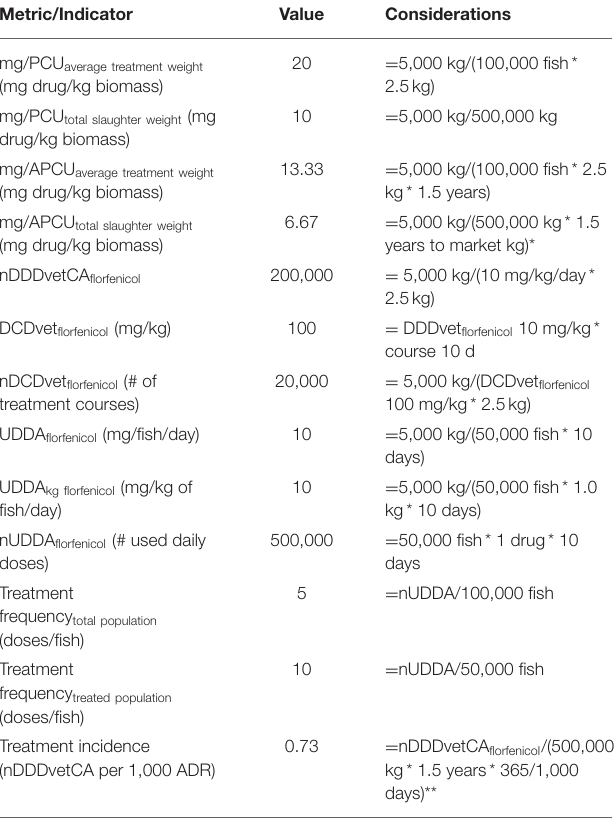
TABLE 3 | Application of antimicrobial use indicators to finfish aquaculture data. Metric/Indicator Value